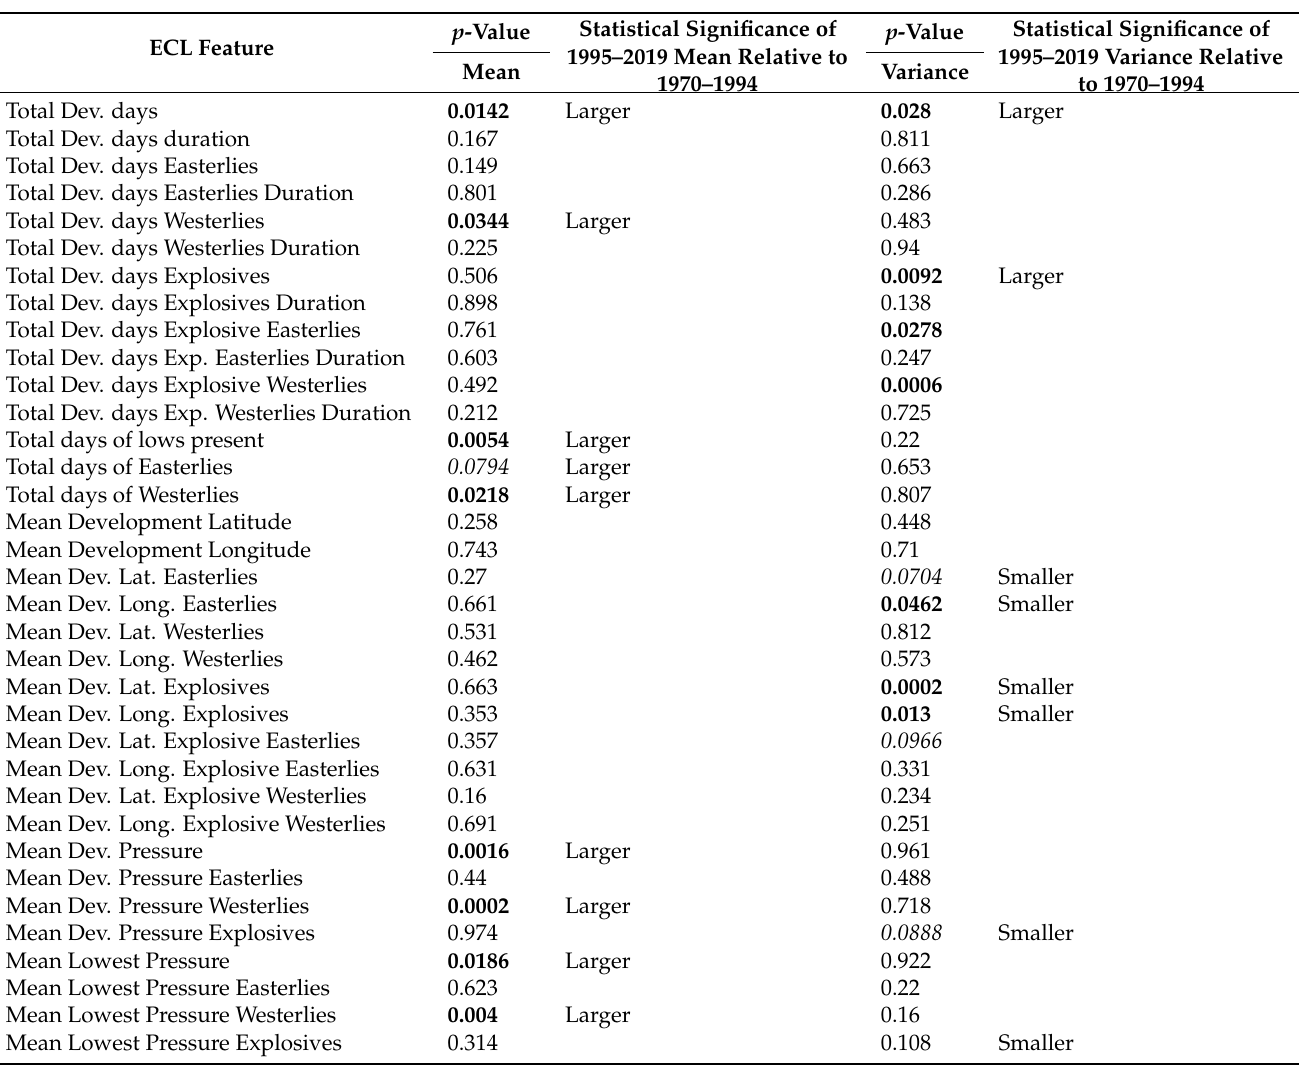
Table 1. p -values of difference in means and variances of ECL grouping between 1970 and 1994 and 1995 and 2019. p -values ≤ 0.05 are in bold and p -values ≥ 0.05 but ≤ 0.1 are in